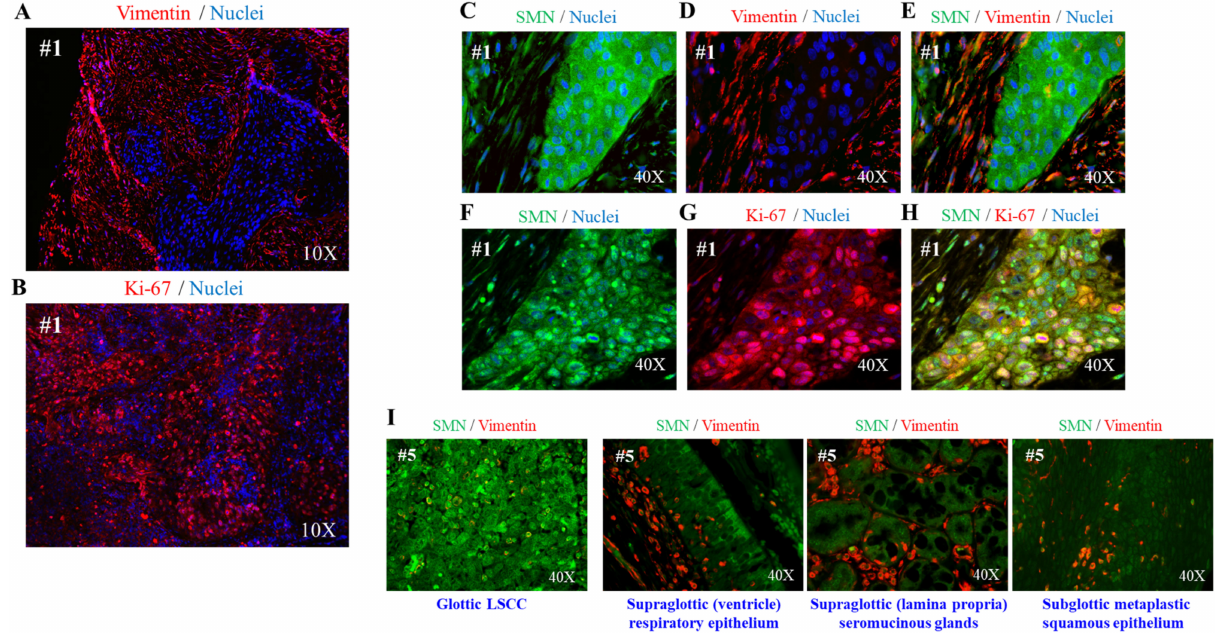
Figure 2. SMN protein is enriched in neoplastic cells of the laryngeal tissue. ( A , B ) Representative images of fluorescence microscopy. De-paraffinized sections of LSCC from patient #1 were stained with an anti-Ki67 antibody or an anti-vimentin antibody. Nuclei were labeled with DAPI (blue). Images were acquired with a 10 × objective, as indicated. ( C – H ) Representative images of immunoflu- orescence analysis visualizing the localization of SMN protein. De-paraffinized sections of LSCC tissue from patient #1 were subjected to dual immunostaining for SMN (green) and vimentin (red) (upper panel, C – E ), or SMN (green) and Ki67 (red) (bottom panel, F – H ). Nuclei were stained with DAPI (blue). ( I ) Representative images of the immunofluorescence for SMN (green) and vimentin (red). Different types of epithelial cells identified in LSCC tissue from patient #5 are displayed. Images were acquired with a 40 ×